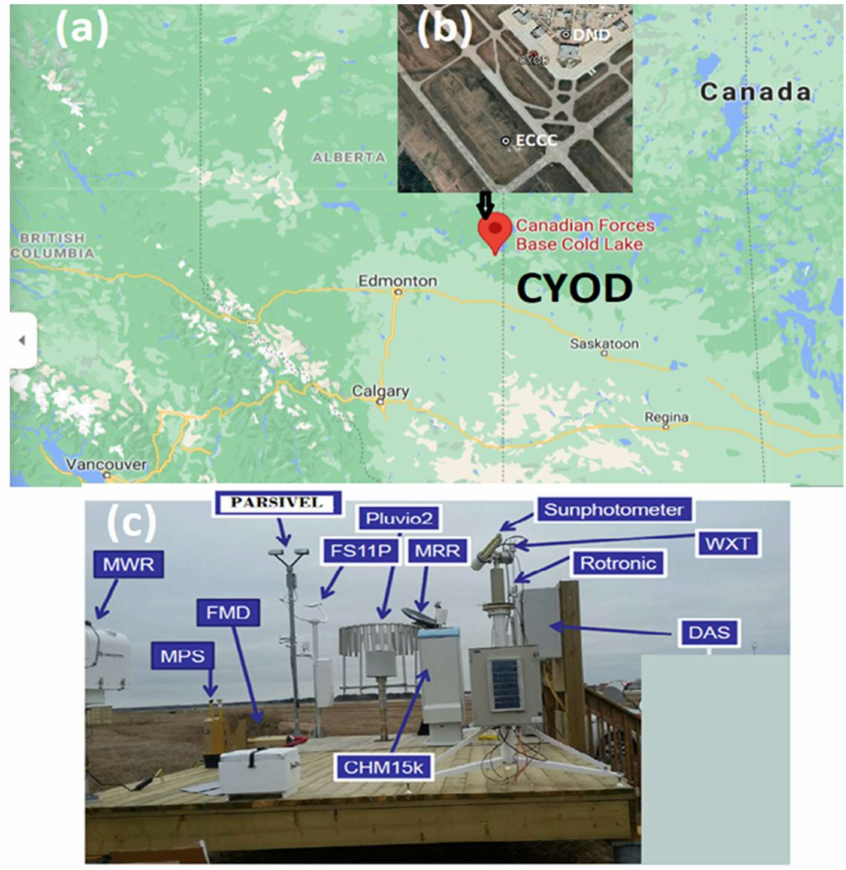
Figure 1. The geographical locations of CYOD (Canadian Air Force base) and the surrounding areas ( a ) and observation sites used in this study are marked as ECCC. A collocated meteorological terminal air report (METAR) observation site used by the DND is also shown ( b ) and the instruments set up at the ECCC site are shown in ( c